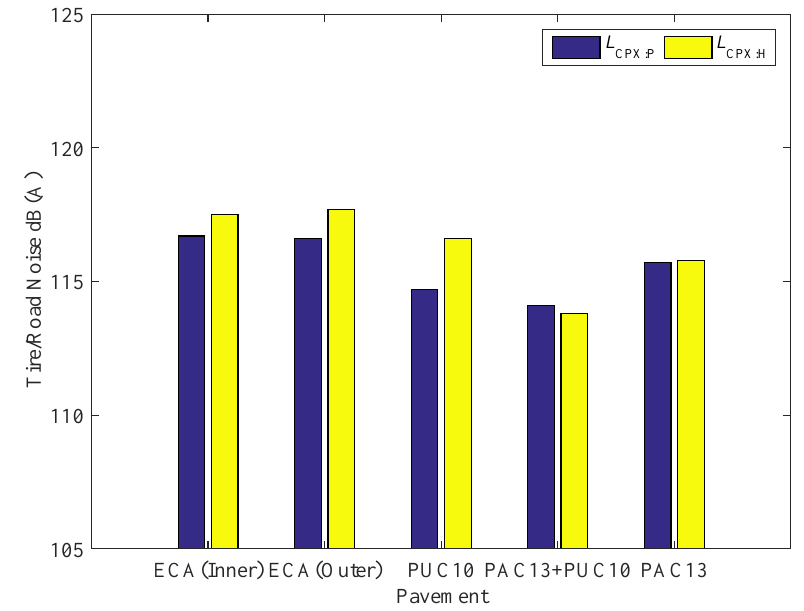
Figure 7. Tire/road noise for different pavements at 80